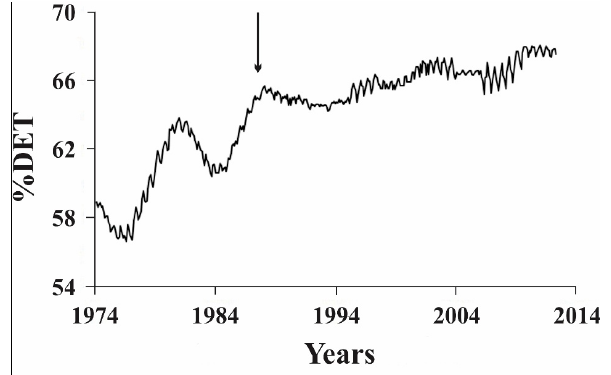
Figure 8. %DET of magnitude data sequences (M2.2 threshold) around the Enguri reservoir (R = 100 km) 1974–2017. Note increased determinism in waiting times after 1986.